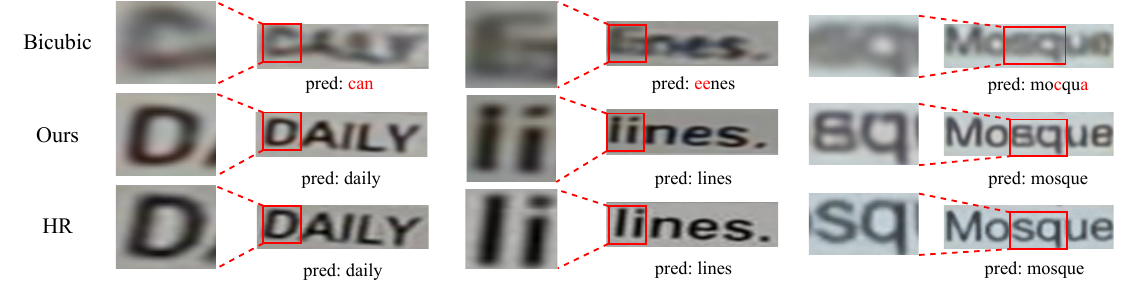
Figure 1. Examples of SR images generated using our MTSR and prediction using ASTER [21] on the TextZoom [12]. Red texts mean the results of